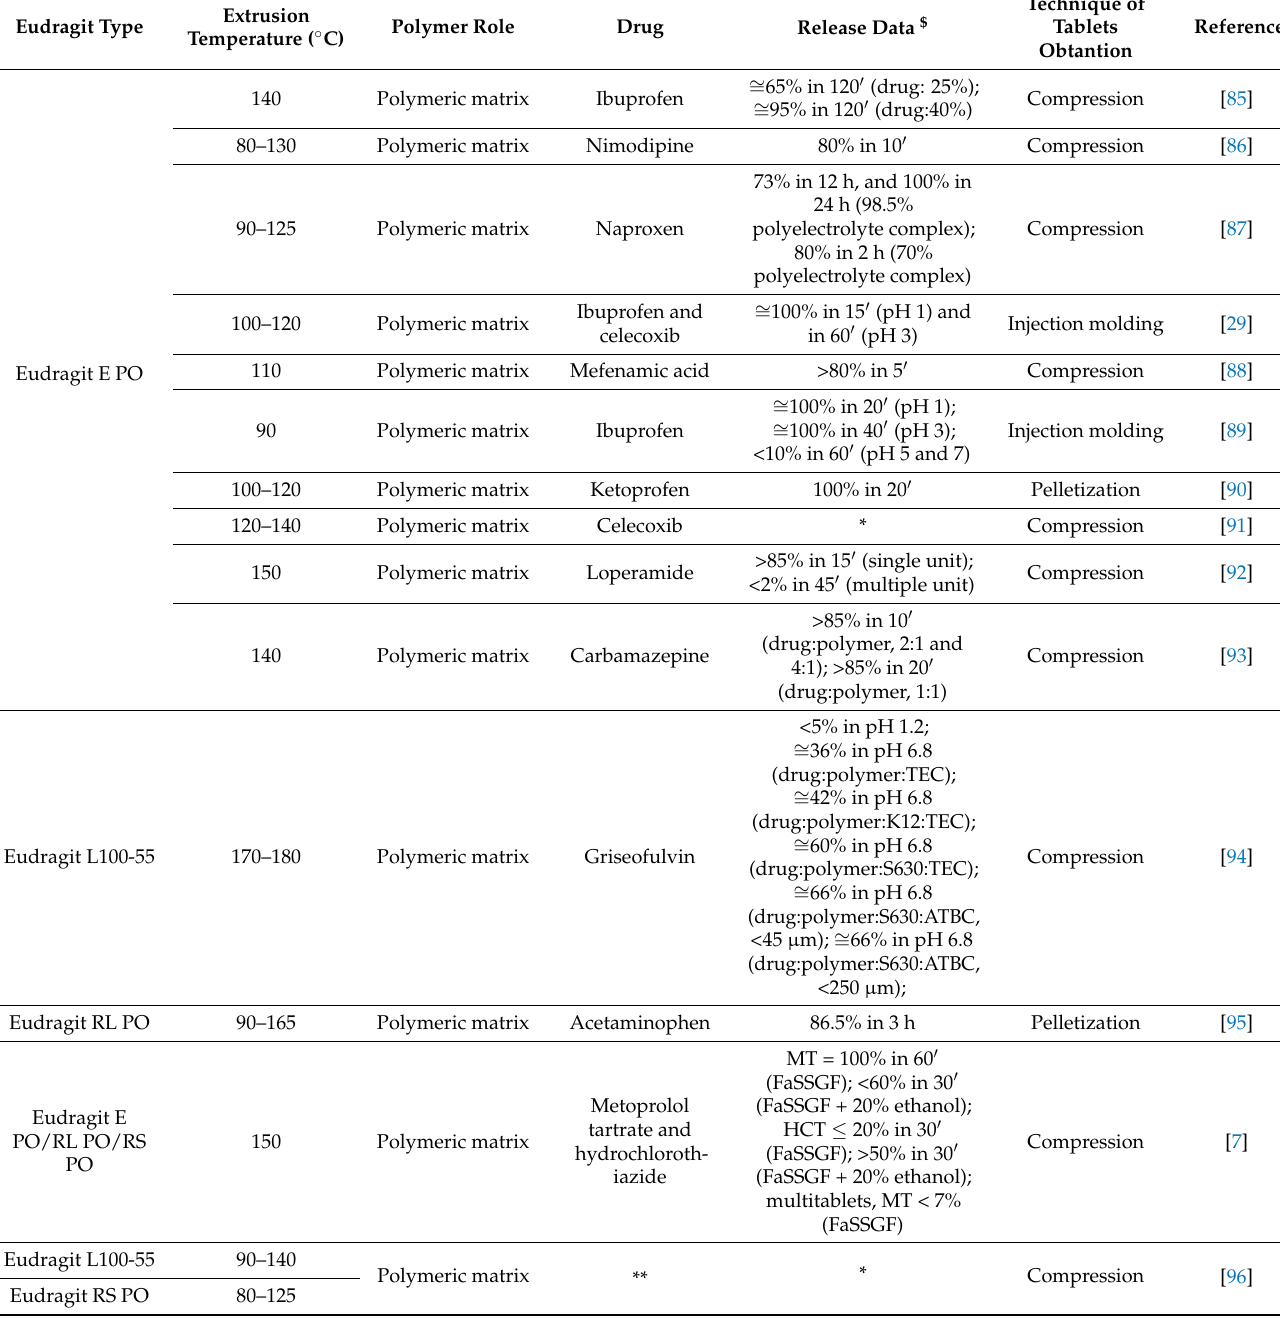
Table 3. Tablets produced from HME products prepared with Eudragit